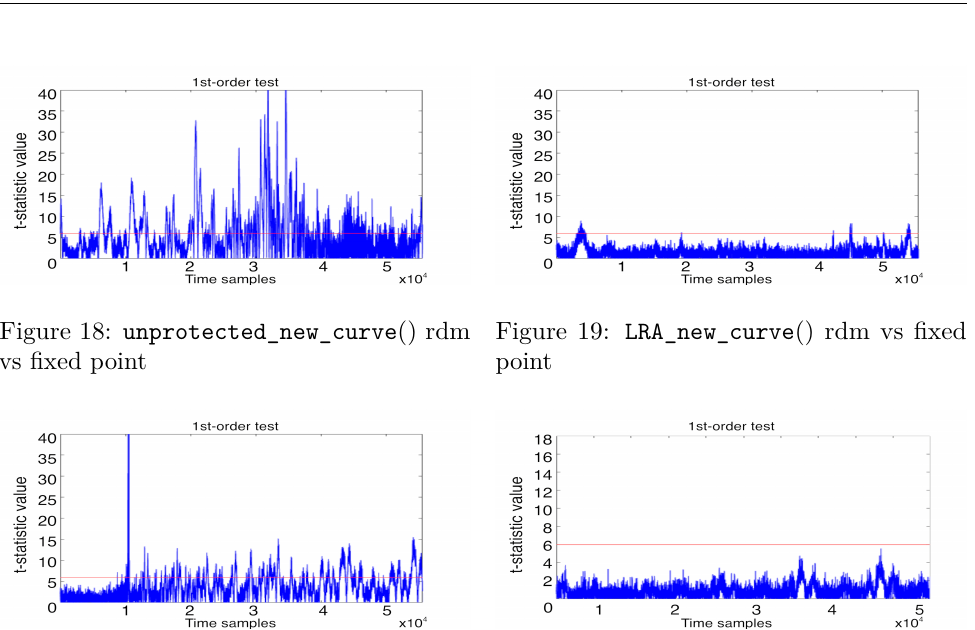
Figure 21: LRA_rdm_point_new_curve () rdm vs fixed point